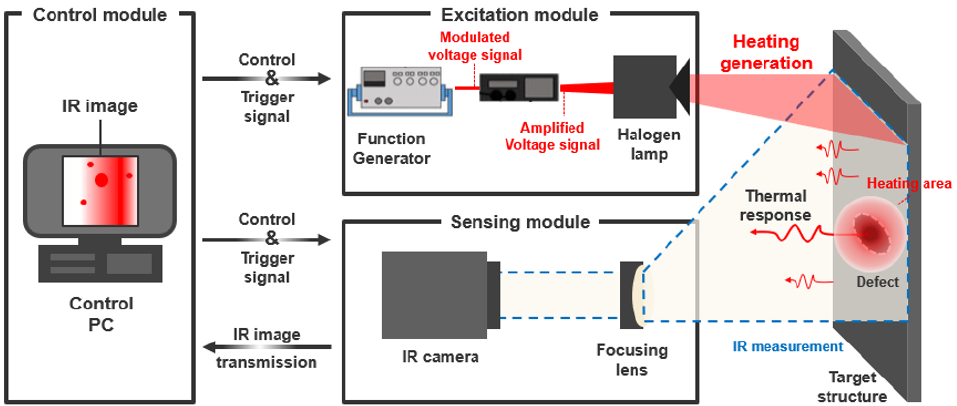
Figure 6. Schematic diagram of the LIT experimental setup for measuring the thermal response of specimen with thinning defects.